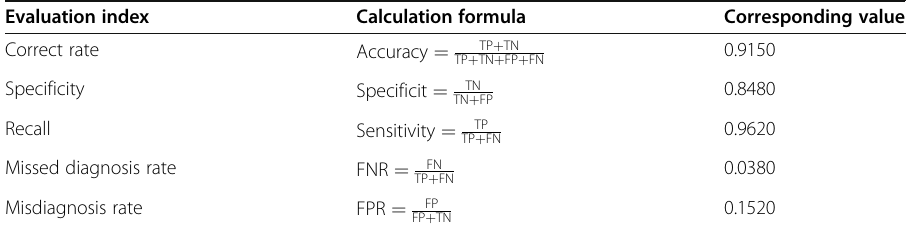
Table 6 Time-ResNeXt network evaluation Evaluation